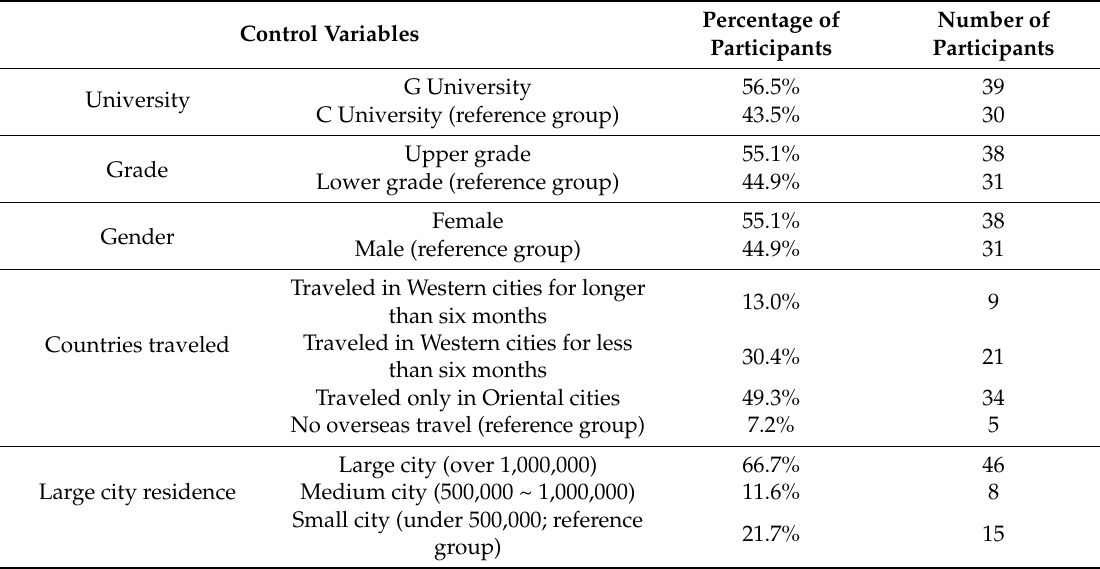
Table 3. Descriptive statistics of control variables.